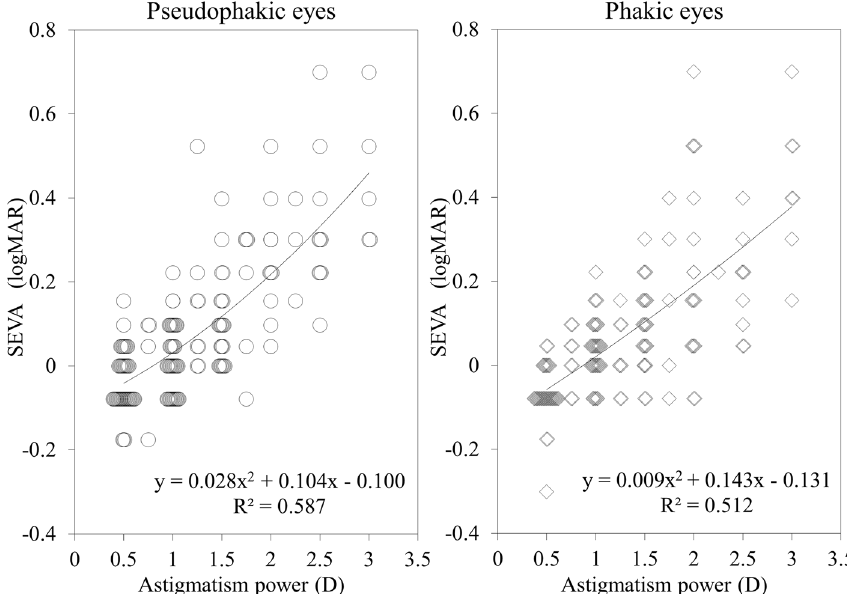
Figure 2. Graphs showing significant correlations between the spherical equivalent visual acuity (SEVA) and the amount of astigmatism in phakic and pseudophakic subgroups (Spearman’s signed-rank test r = 0.718, p < 0.001, and r = 0.717, p < 0.001).